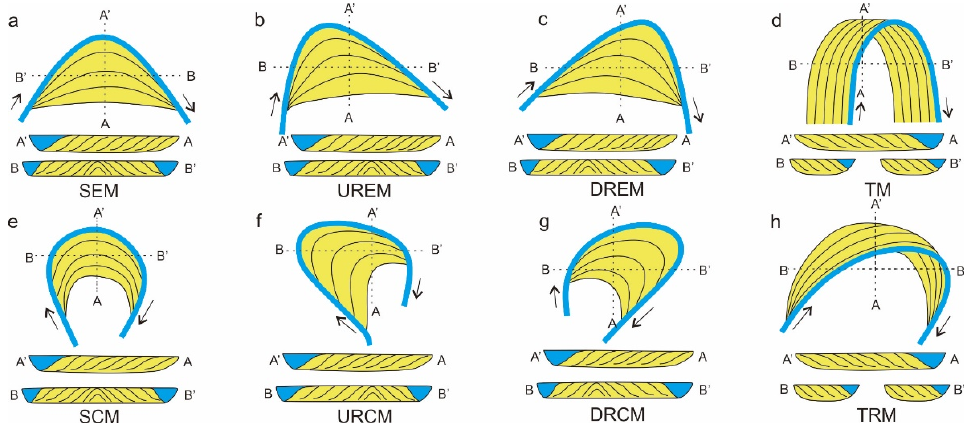
Figure 12. Stratigraphic sequence of single planform modes, ( a – h ) similar to that in Figure 1.